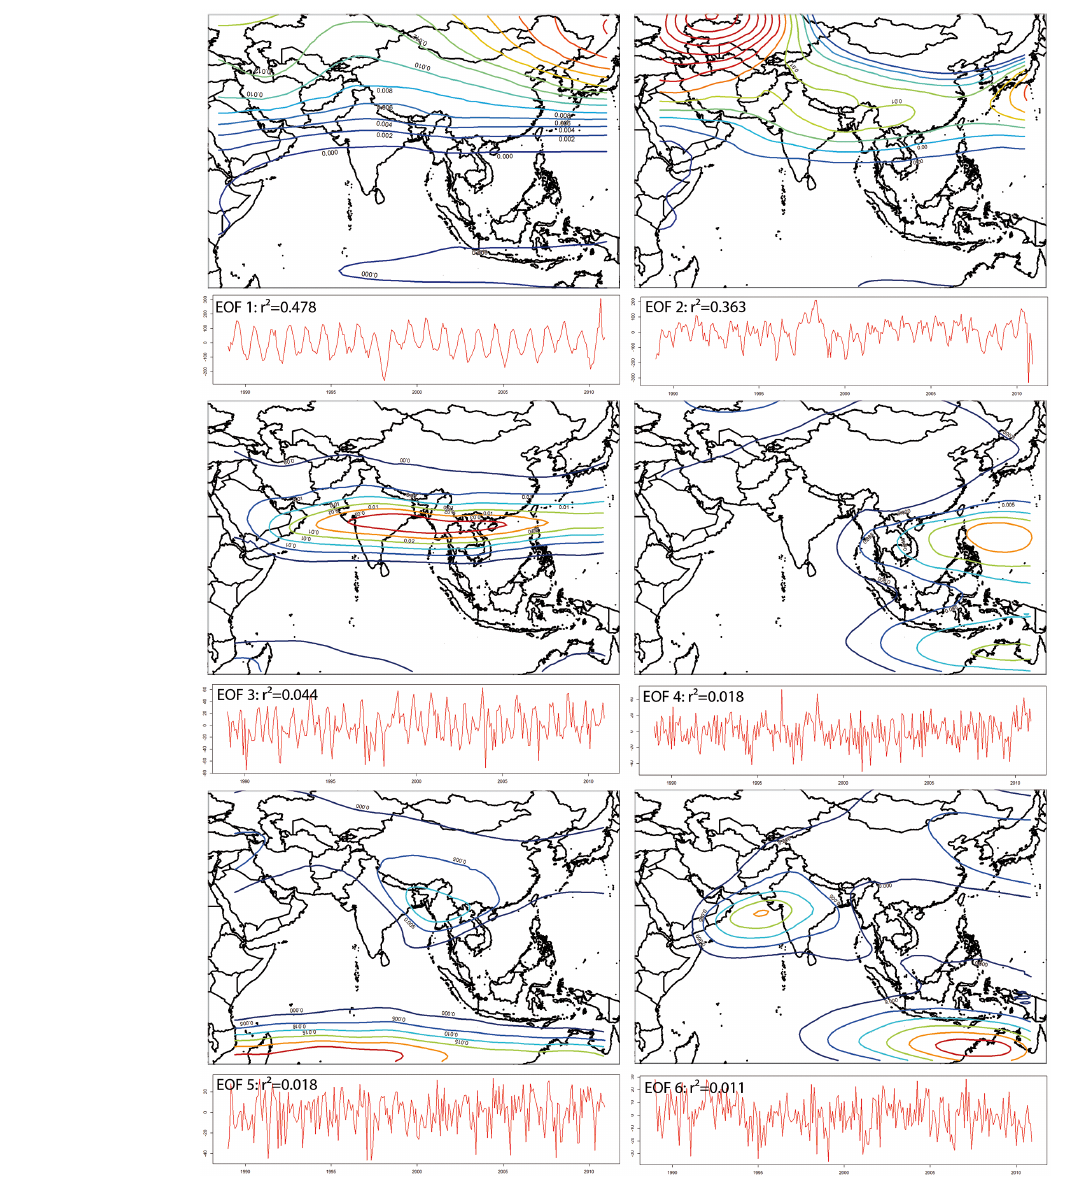
Figure 2. Spatial modes and time series of scores for the first six EOFs of the 500hPa GPH anomaly over the macrogeographical region. Blue (red) lines indicate low (high) values of the particular